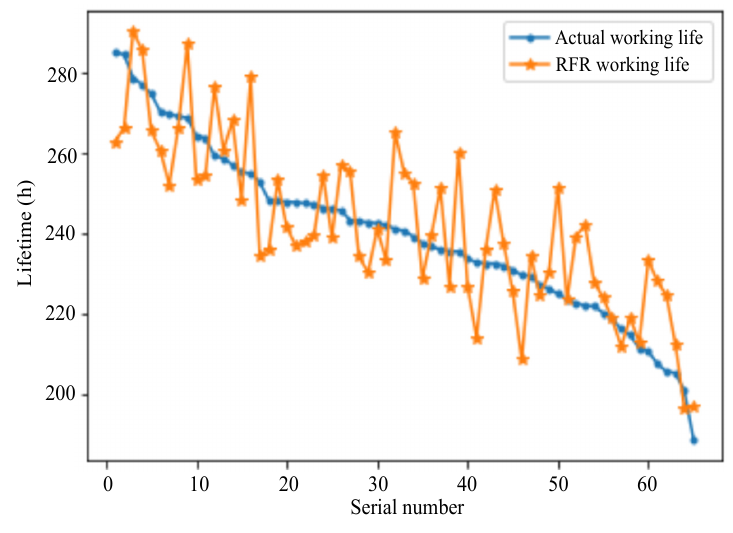
Figure 8. RFR model.